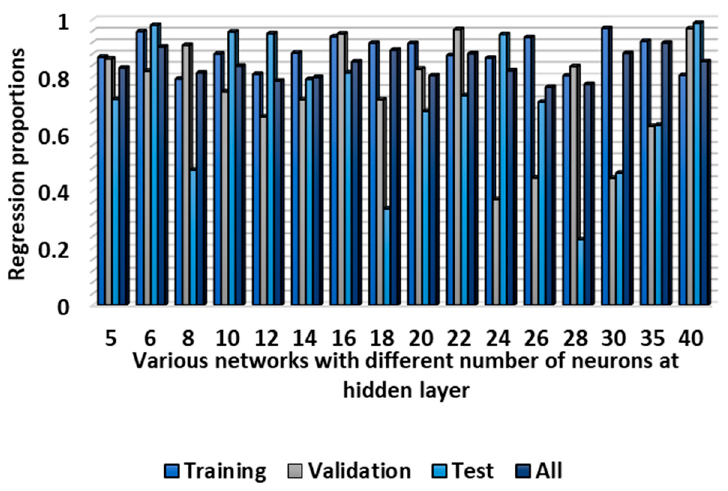
Figure 7. Various correlation coefficients of NN 10-n-1.